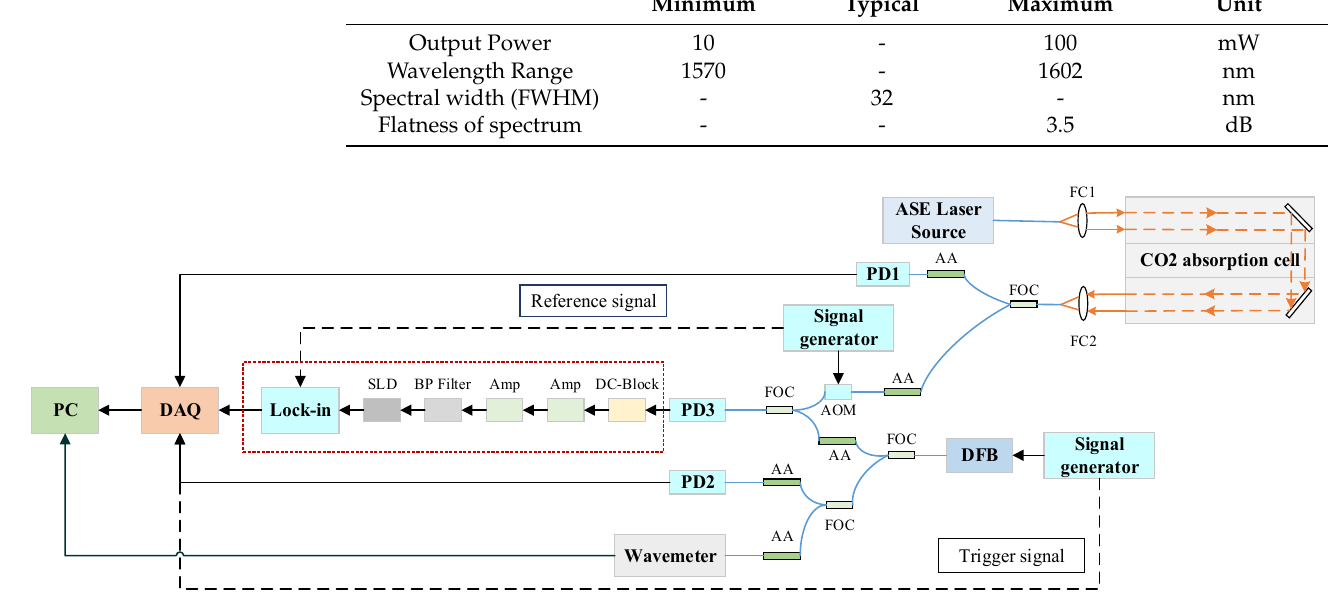
Figure 1. Diagram of experimental setup for LHR performance evaluation based on a CO 2 absorption cell. AA, adjustable attenuator; FOC, fiber-optic coupler; FC, fiber collimator, Amp, amplifier; BP Filter, bandpass filter; SLD, square-law detector; PD1, photodetector 1; PD2, photodetector 2; PD3, photodetector 3.